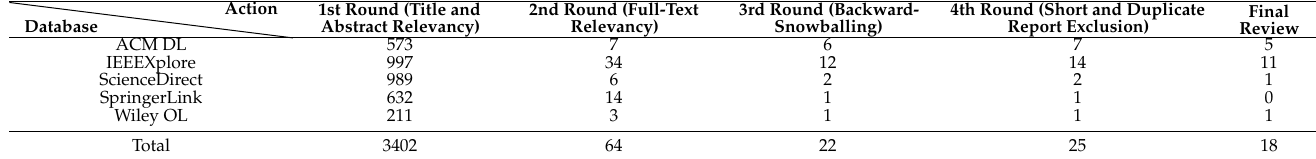
Table 3. Number of studies retrieved from the selected databases.